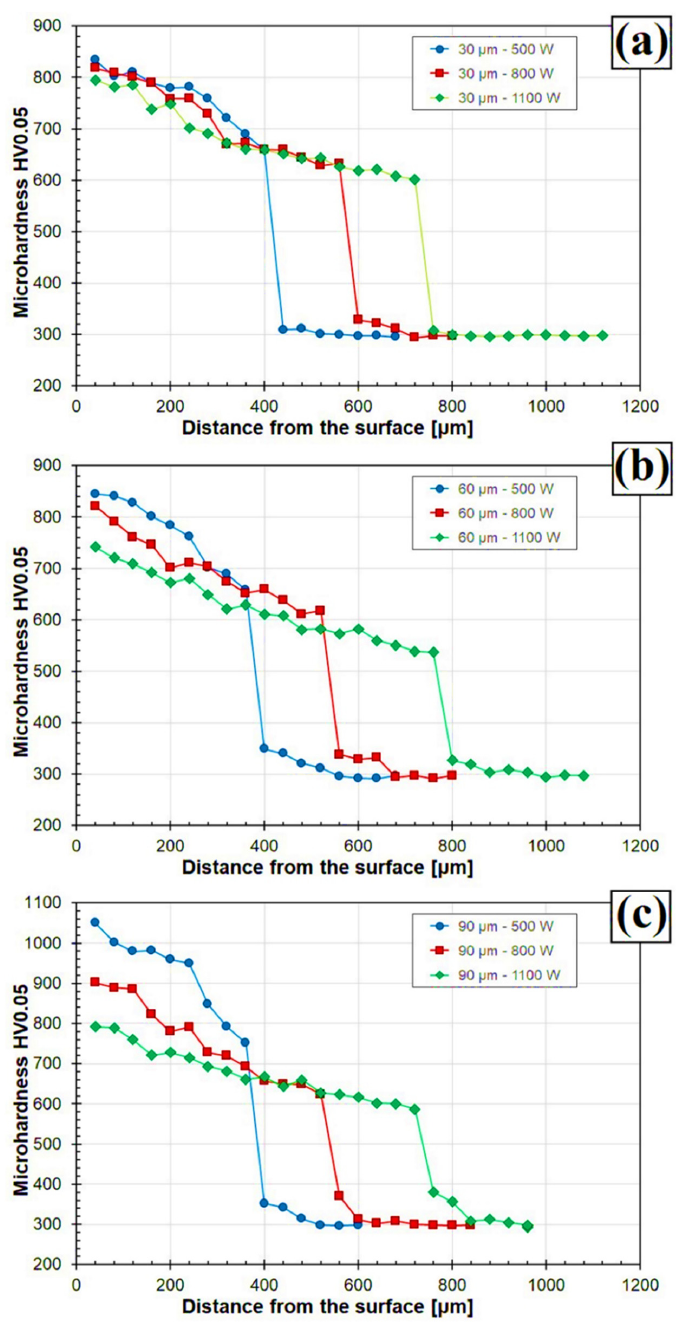
Figure 17. Microhardness profiles for Fe/TaC coatings produced using laser beam power 500 W, 800 W, 1100 W and applied pre-coat with thickness of: 30 µm ( a ), 60 µm ( b ), 90 µm ( c ).